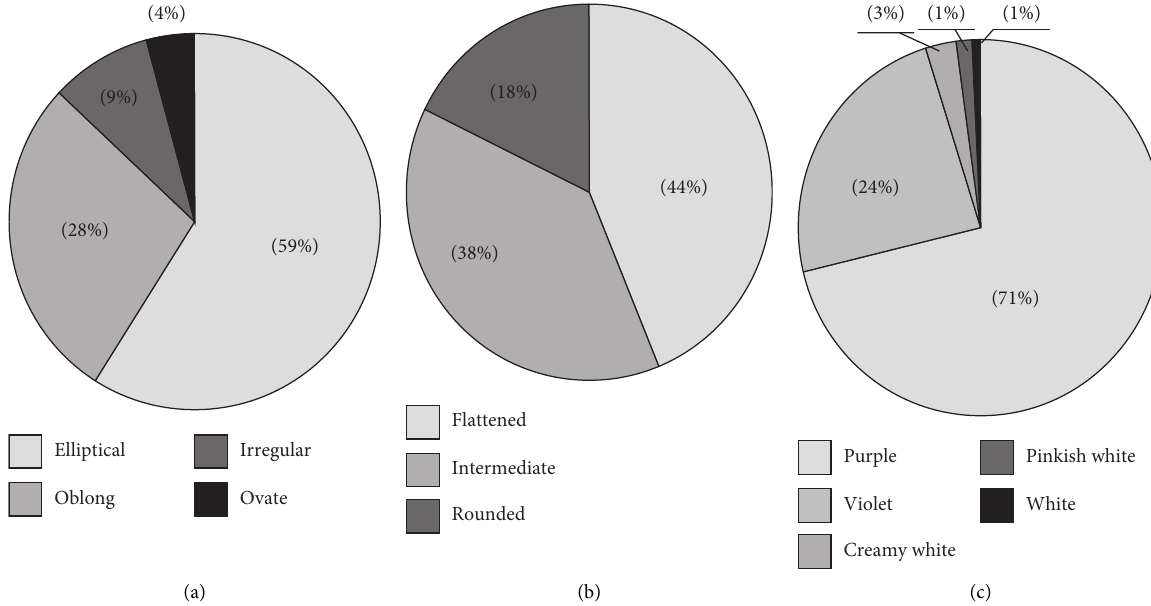
Figure 5: Morphological characteristics of the seeds of 146 fine-flavor native ecotypes. (a) Seed form in the longitudinal section. (b) Seed form in the transverse section. (c) Cotyledon